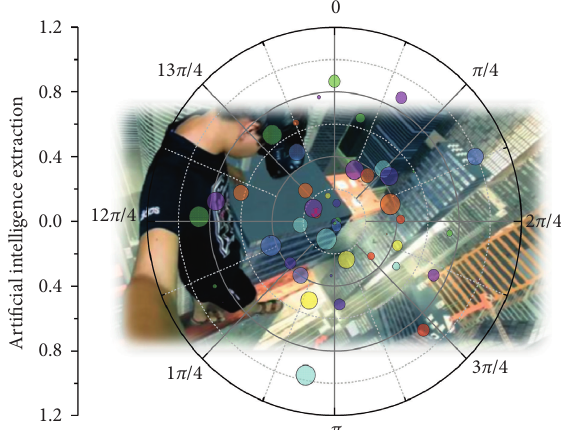
Figure 4: User addition